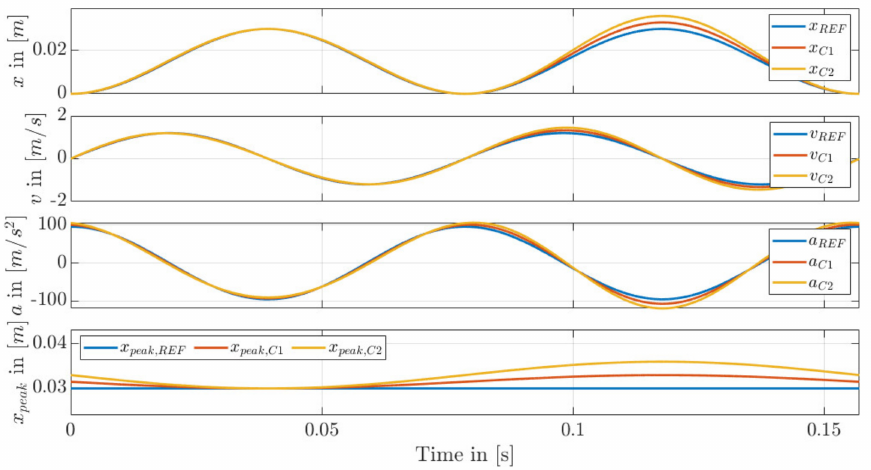
Figure 12. Comparison between the reference curve and stroke amplitude variation in the operating point ω = 80 rad/s, ˆ x 1 = 0.03 m, ˆ x 2 = 0.033 m and ω = 80 rad/s, ˆ x 1 = 0.03 m, ˆ x 2 = 0.036